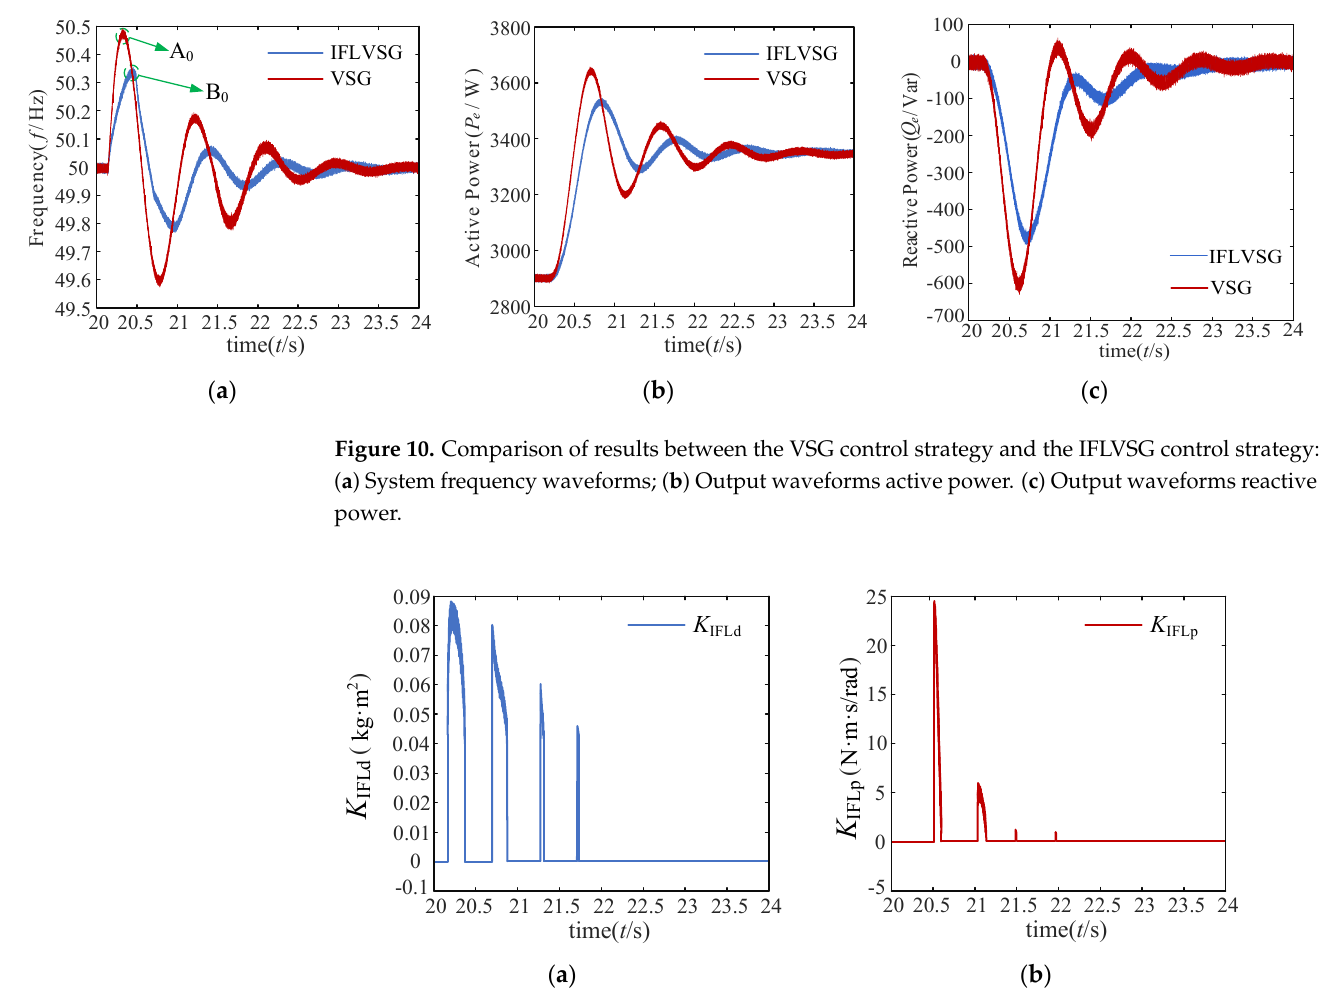
Figure 10. Comparison of results between the VSG control strategy and the IFLVSG control strategy: ( a ) System frequency waveforms; ( b ) Output waveforms active power. ( c ) Output waveforms reac ‐ tive power.